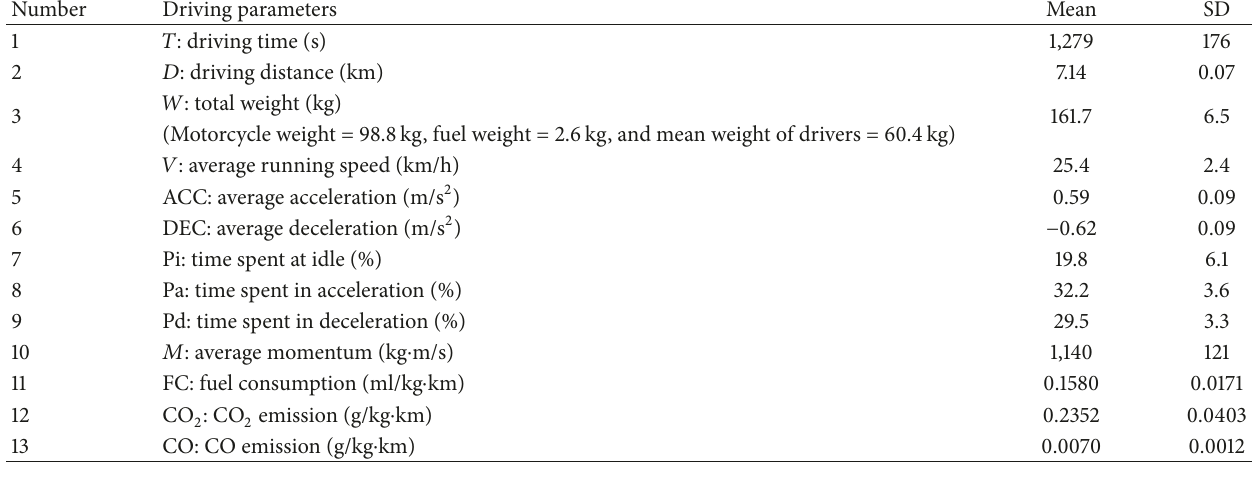
Table 1: Results of descriptive statistics analysis on on-road driving data.